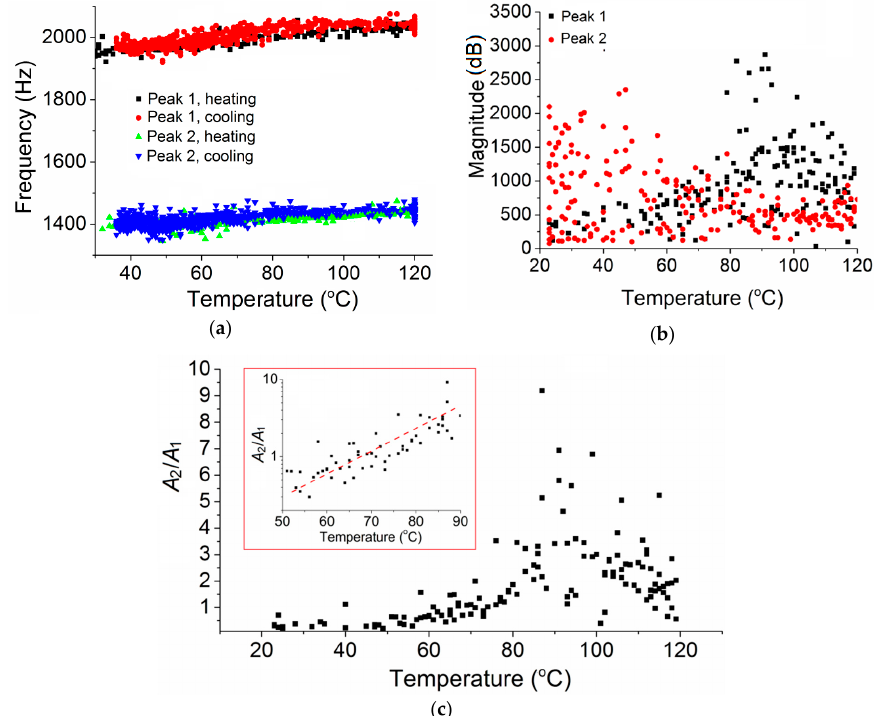
Figure 3. ( a ) The frequency changes of Peak 1 and Peak 2 with temperature; ( b ) the magnitude changes of Peak 1 and Peak 2 with temperature; and ( c ) the magnitude ratio ( A 2 / A 1 ) change with temperature (the inset is with logarithmic vertical scale).